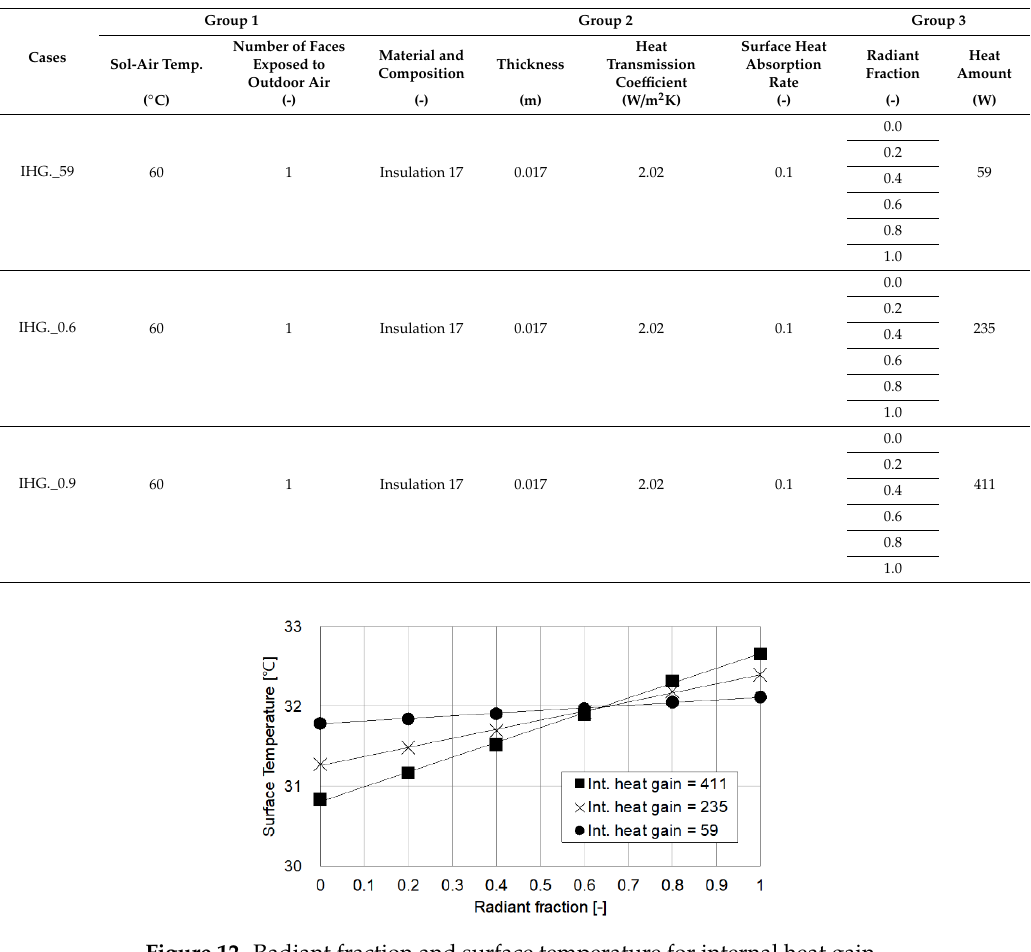
Table 14. Cases for component of internal heat gain (exposed to outdoor air).